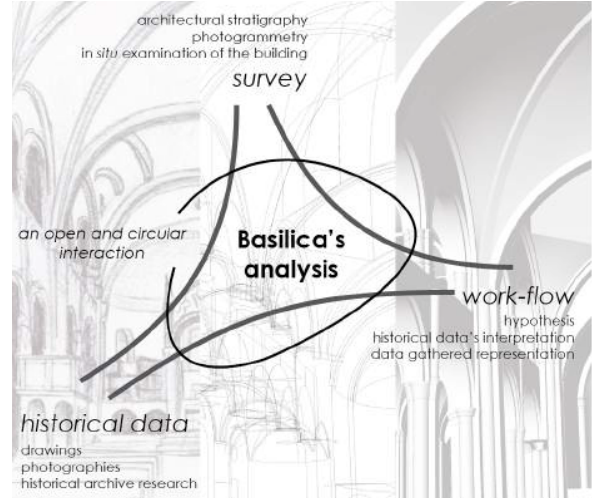
Figure 2. Circular interaction between the involved